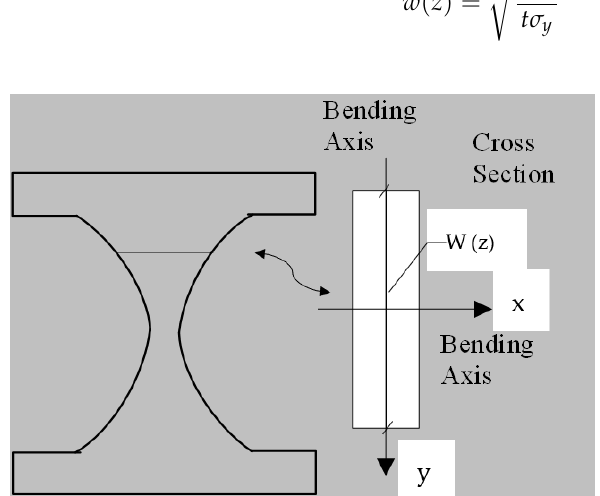
Figure 2. The schematic concept of uniform yielding for the shear damper design.